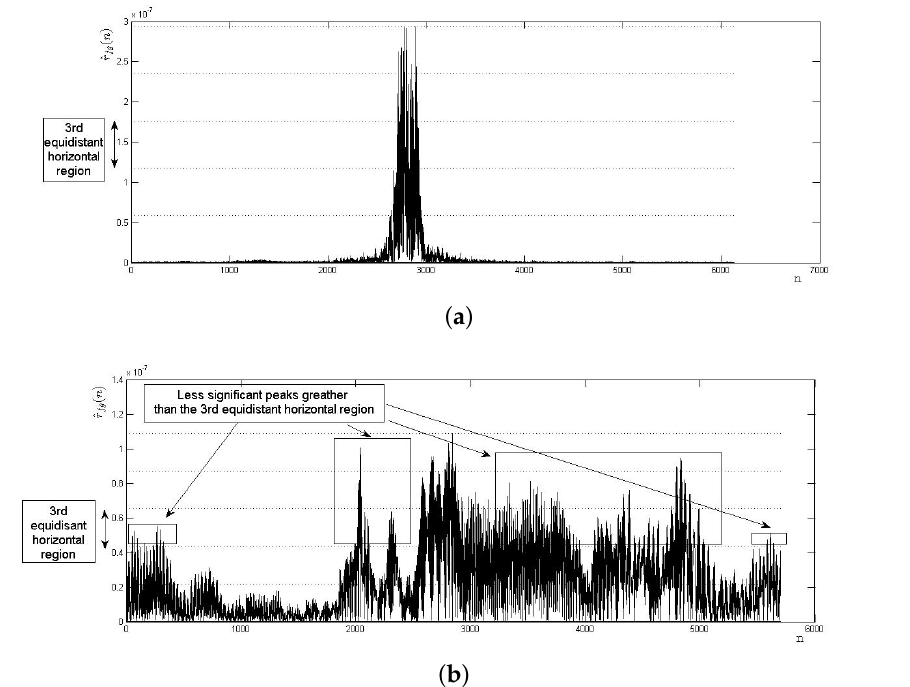
Figure 12. Examples of the BLPOC function verification process through equidistant horizontal regions: ( a ) a genuine matching correctly verified as accepted; and ( b ) impostor matching correctly verified as